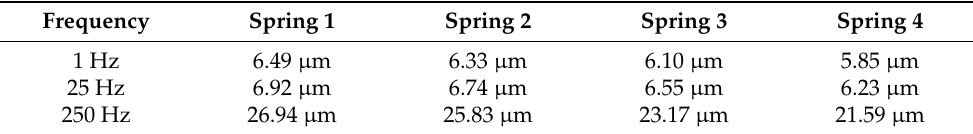
Figure 4. The influence of different dynamic forces: ( a ) 1, ( b ) 25, and ( c ) 250 Hz. Table 2. Width of hysteresis loops under different dynamic forces.